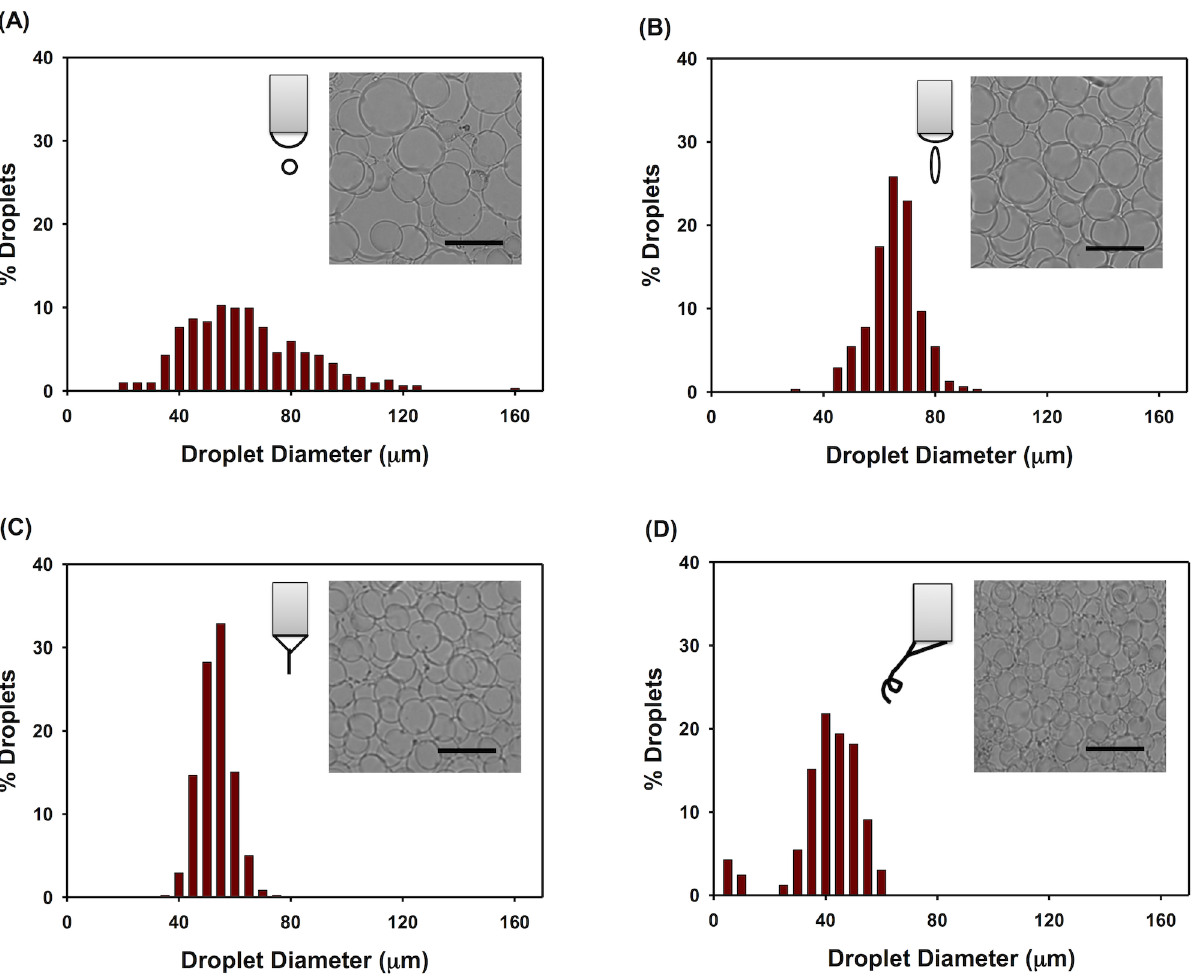
Fig 2. Deposited droplet size histogram obtained from different eletrospraying modes. Four eletrospraying modes were analyzed: (A) micro-dripping mode at electric field of 1.3 kV/cm, (B) spindle mode at electric field of 1.4 kV/cm, (C) cone-jet mode at electric field of 1.5 kV/cm, and (D) precession mode at electric field of 1.6 kV/cm. The optical microscopy images of the deposited droplets are shown in the inset Figs with scale bars of 100 μ m.